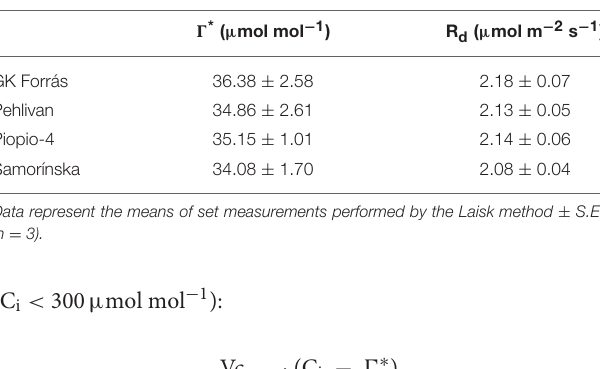
TABLE 1 | The CO 2 compensation point in the absence of respiration ( Ŵ * ; µ mol mol − 1 ) and the mitochondrial respiration rate under light (R d ; µ mol m − 2 s − 1 ) as measured in four wheat genotypes under well-watered